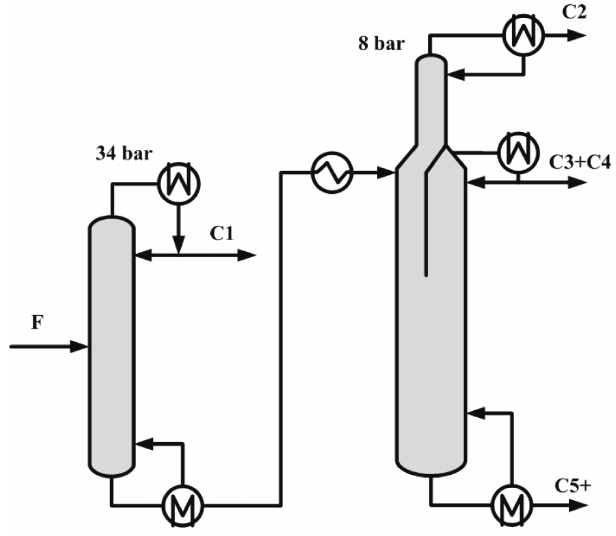
Fig. 2 – Conventional demethanizer & dividing wall column